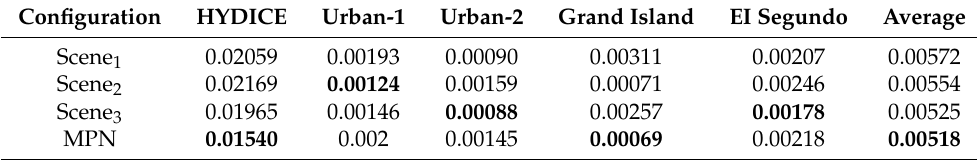
(cid:16) (cid:17) P f , τ for different scenes on different datasets.